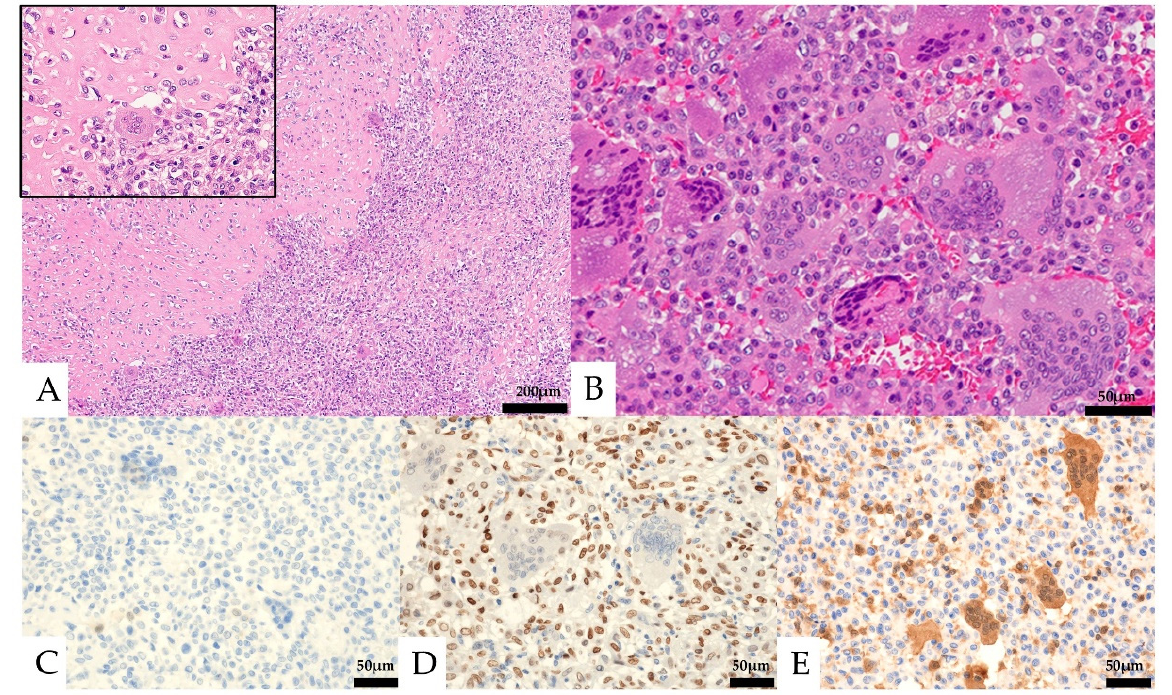
Figure 4. Pathological images of the initial nephrectomy. ( A , B , Hematoxylin and eosin staining) osteoid formation was seen in part of the tumor ( A , left and insert). Mononuclear cells and multinu- cleated giant cells were observed ( B ). ( C – E ) Immunohistochemical features. Both the mononuclear cells and the multinucleated giant cells were negative for CK AE1/AE3 ( C ). The mononuclear cells were positive for SATB2 ( D ). Loss of MTAP expression was seen in the mononuclear cells ( E ). Table 1. Immunohistochemical findings of the primary renal specimen and the retroperitoneal tu- mor